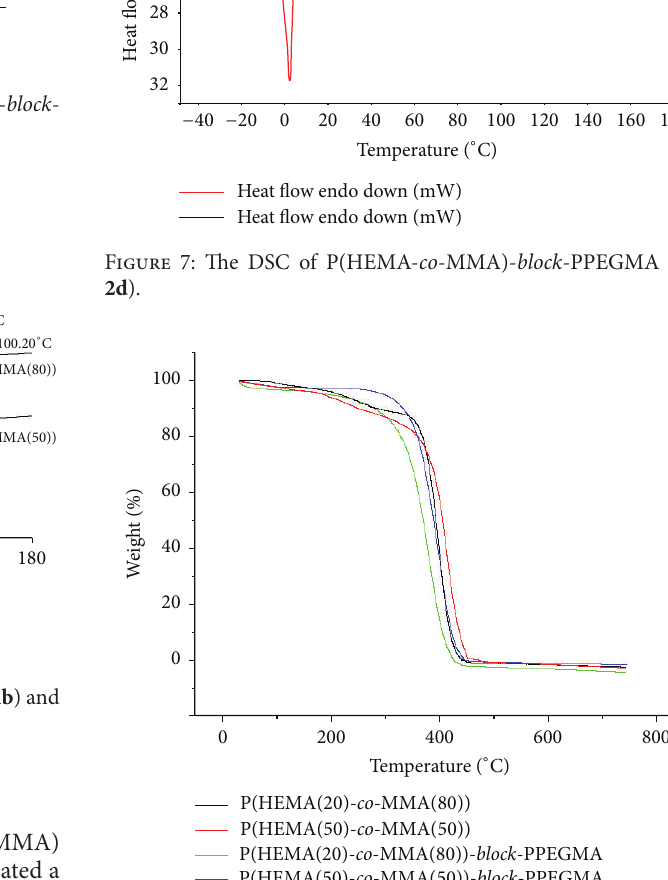
Propargyl side-functional block copolymers, alkyne- P(HEMA- co -MMA)- block -PPEGMA ( 3b and 3d ), were pre- pared by the Steglich esterification between hydroxyl groups of HEMA and propiolic acid in the presence of DCC